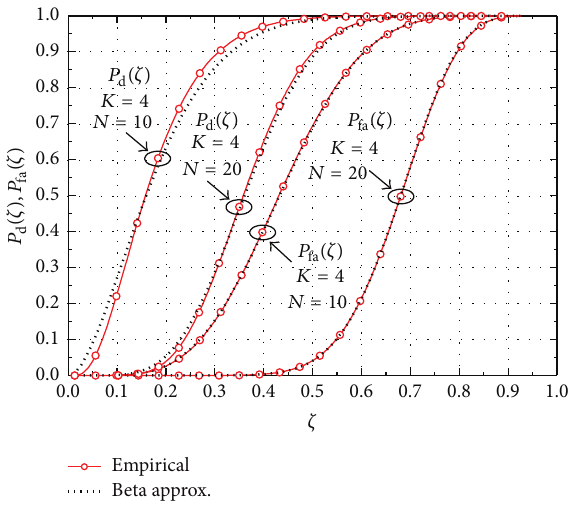
Figure 3: False alarm and detection probabilities of the ST: Beta approximation versus simulation, for 𝐾 = 4, 𝑁 = 20, and 𝑁 = 10, = 5 dB, SNR = 3 dB, and SNR = 0 𝑃 = 3, SNR 1 2 3